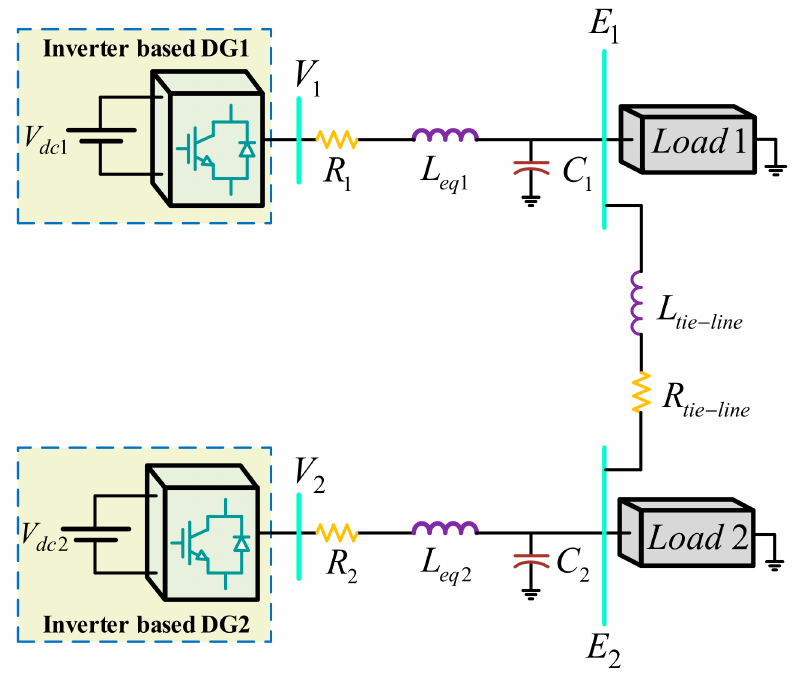
Figure 4. Parallel operation of the islanded microgrid under study via a tie-line